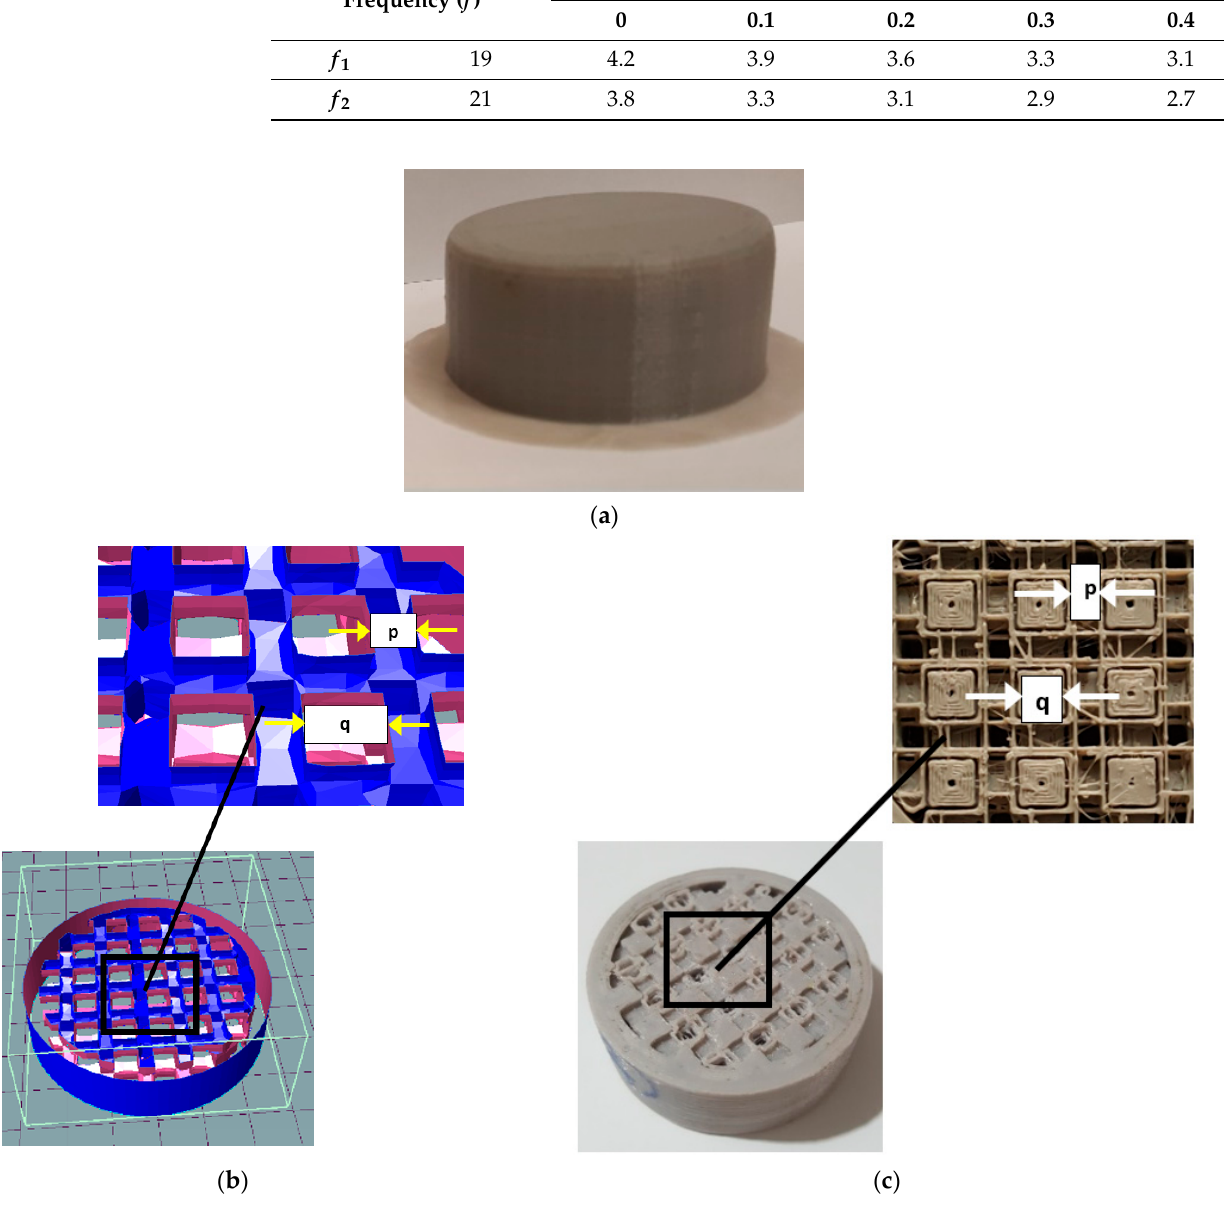
Figure 7. External and Internal geometry ( a ) Outer shape of the specimen after printing ( b ) X-sectional view, illustrating internal structure of the test specimen and related dimensions after rendering ( c ) X-sectional view illustrating internal structure of the test specimen and related dimensions after printing.